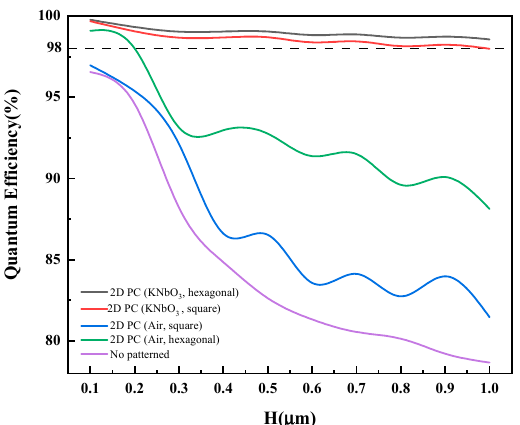
Figure 9. Quantum efficiencies of absorption layers with different types of scatterers.